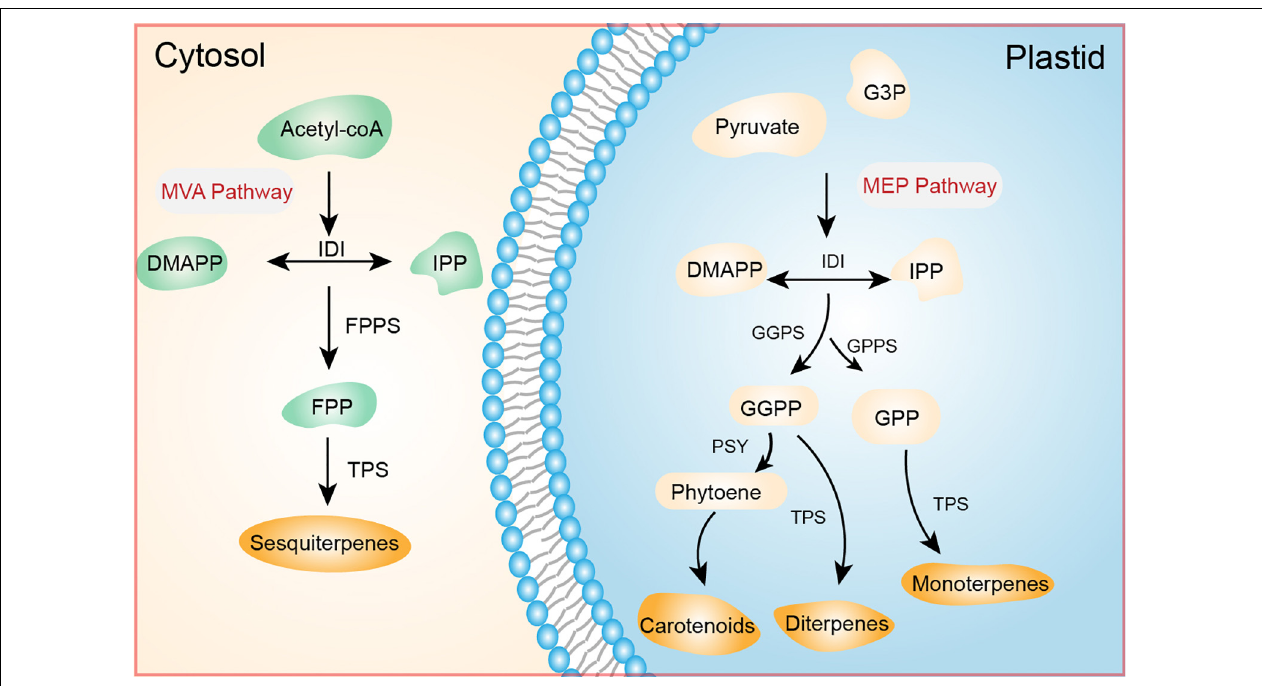
FIGURE 1 | Terpenoid biosynthetic pathway. Terpenoid precursors (acetyl-CoA and pyruvate) enter the MVA pathway in the cytosol to produce sesquiterpenes or the MEP pathway in plastids to generate monoterpenes, diterpenes, and carotenoids. The enzymes and intermediates of both pathways are shown. DMAPP, dimethylallyl diphosphate; FPP, farnesyl diphosphate; FPPS, farnesyl pyrophosphate synthase; GGPP, geranylgeranyl pyrophosphate; GGPS, geranylgeranyl pyrophosphate synthase; GPP, geranyl diphosphate; GPPS, geranyl diphosphate synthase; IDI, isopentenyl diphosphate isomerase; IPP, isopentenyl diphosphate; PSY, phytoene synthase; TPS, terpenoid